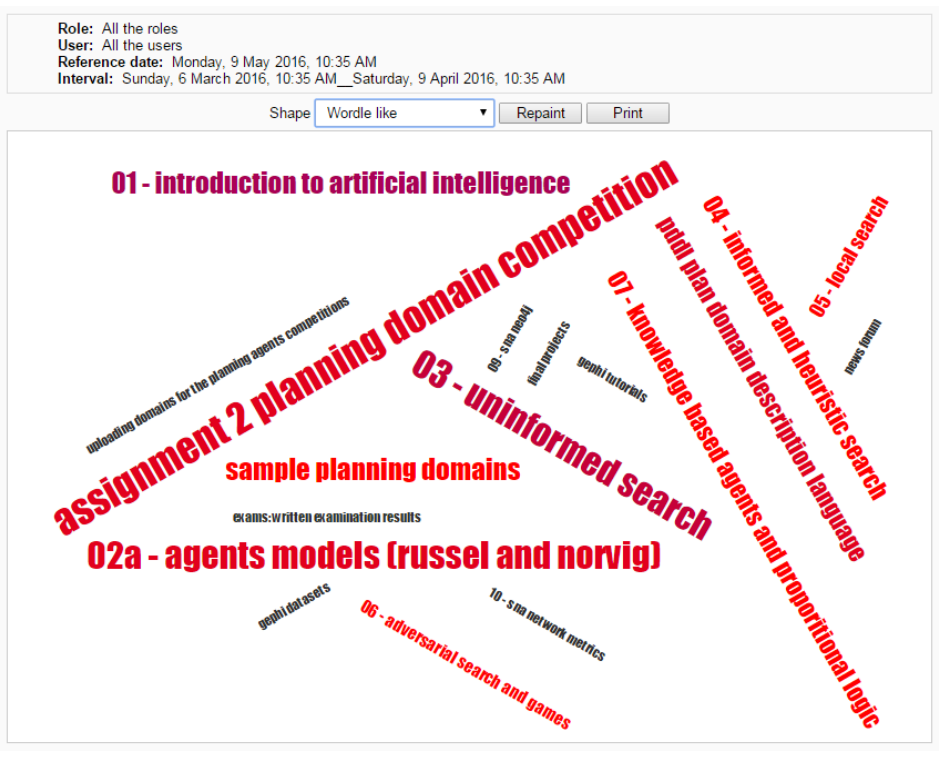
Figure 8. Tag cloud mode in Wordle style.